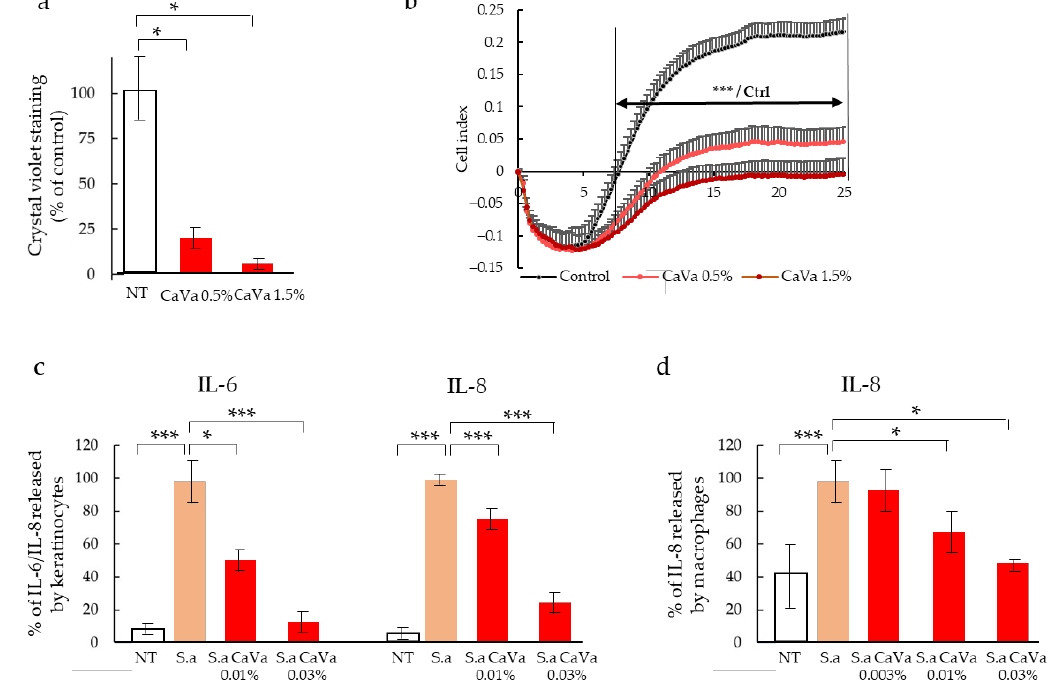
Figure 6. Decrease in S. aureus virulence induced by a Castanea sativa extract. ( a , b ) S. aureus was cultured within trypticase soy broth for 24 h at 37 °C without (NT) or with an extract of Castanea Sativa (CaVa) at the indicated concentration (n = 5). Biofilm formation was measured after crystal violet staining of adherent bacteria ( a ). Electric impedance reflecting instantaneous biofilm for- mation was recorded ( b ). Monolayer cultures of keratinocytes ( c ) and macrophages ( d ) were in- fected by S. aureus without ( S.a ) or with the plant extract, and release of IL-6 or IL-8 was quantified using ELISA (n = at least 3). Mann – Whitney test vs. control. Mean +/ − SD; *, p < 0.05; ***, p < 0.001. The highest amount of cytokines was arbitrarily fixed to 100.